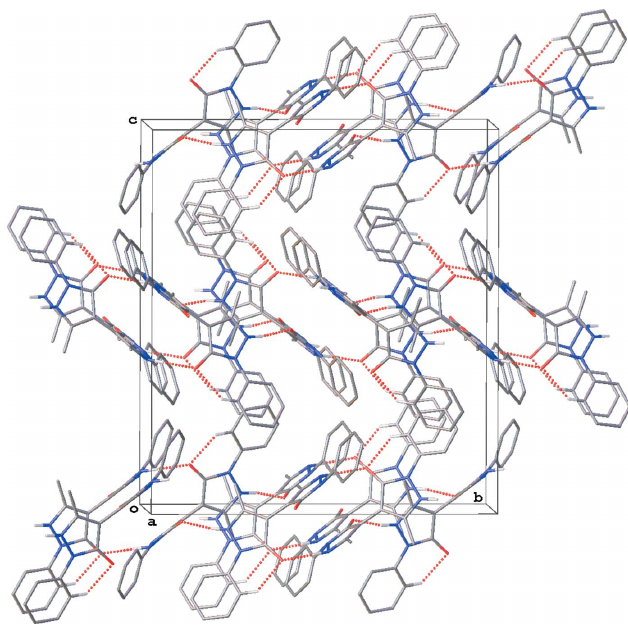
Figure 1 The title molecule with the labeling scheme and displacement ellipsoids drawn at the 50% probability